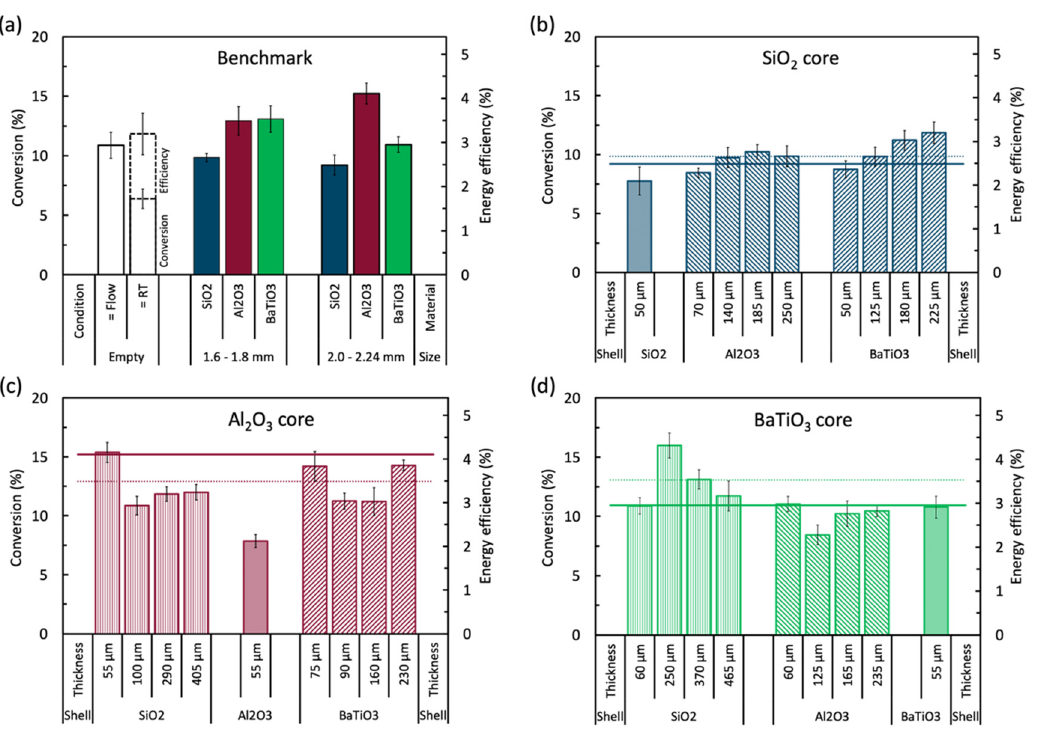
Figure 1. Overview graph of the conversion and energy e ffi ciency of ( a ) the benchmark results (i.e., empty reactor and packed reactor with pure spheres [5]), and all core-shell samples with ( b ) SiO 2 core, ( c ) Al 2 O 3 core, and ( d ) BaTiO 3 core. All core-shell samples were coated with SiO 2 , Al 2 O 3 , and BaTiO 3 powder in di ff erent shell thicknesses, as indicated in each figure. All measurements were performed at 30W, 38.98 mL / min, and 1 bar; except for the empty reactor, which was also evaluated at the same residence time as the packed reactors (79.96 mL / min). The dotted and solid lines are the performance of the corresponding core spheres in their small and big size, respectively. The exact values can be found in Table A1 in Appendix A.